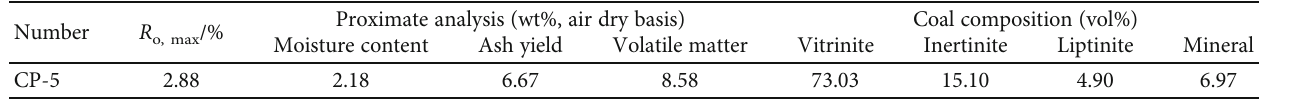
Figure 1: Diagram of the typical coal fi nes assemblage and morphology. (a) Diagram of the typical coal fi nes assemblage and morphology in coal seam #3 in the southern Qinshui Basin. (b) Diagram of the coal fi nes assemblage and morphology in a typical fault zone in coal seam #3 in the southern Qinshui Basin (Zhao et al. 2016). Table 1: Properties of coal samples at the study